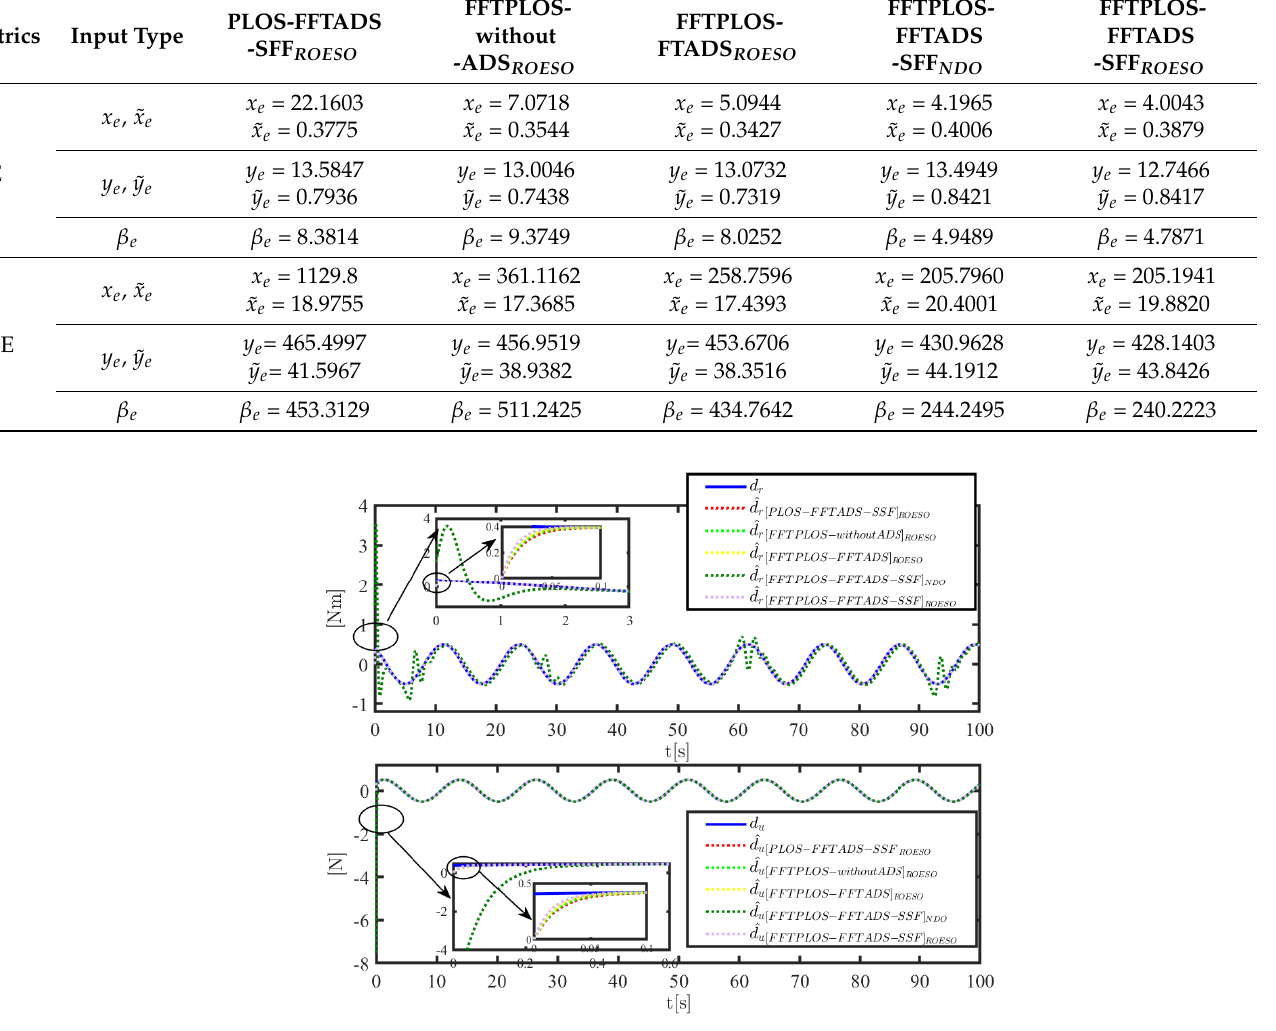
Figure 8. The time-varying disturbances and its estimations. Table 3. The estimation disturbance performance of different